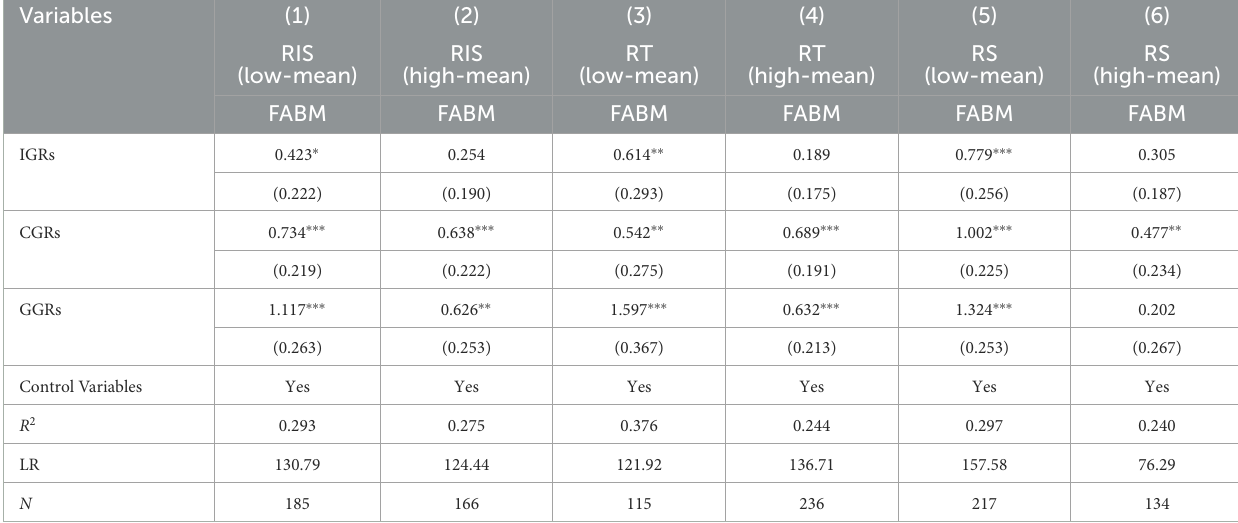
TABLE 9 Effects of IGRs, CGRs, and GGRs on farmers’ adoption of biosecurity measures in different groups.